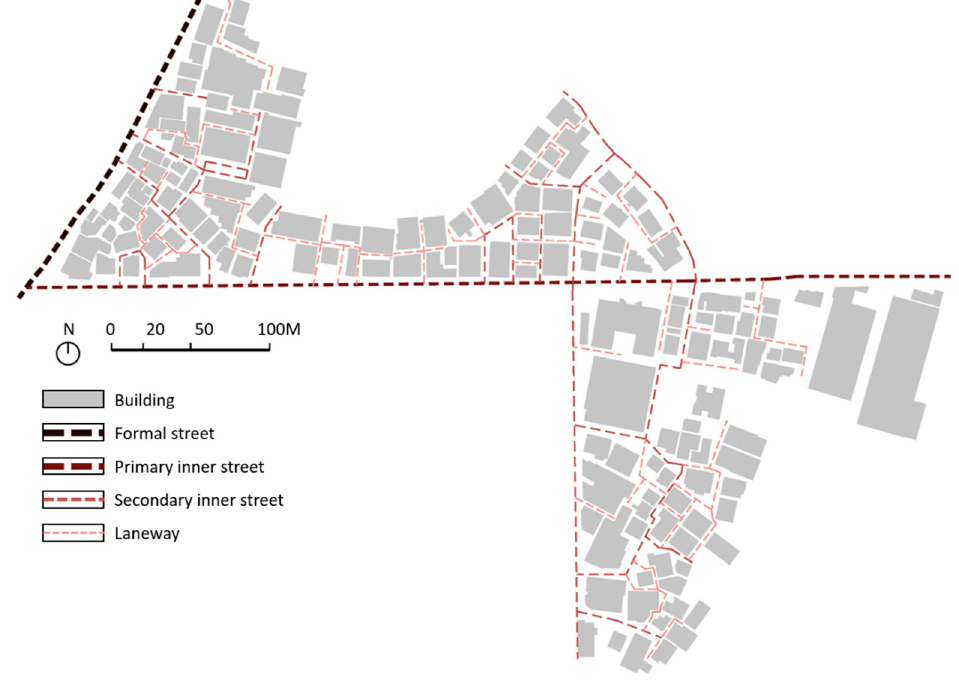
Figure 3. Map of street network.